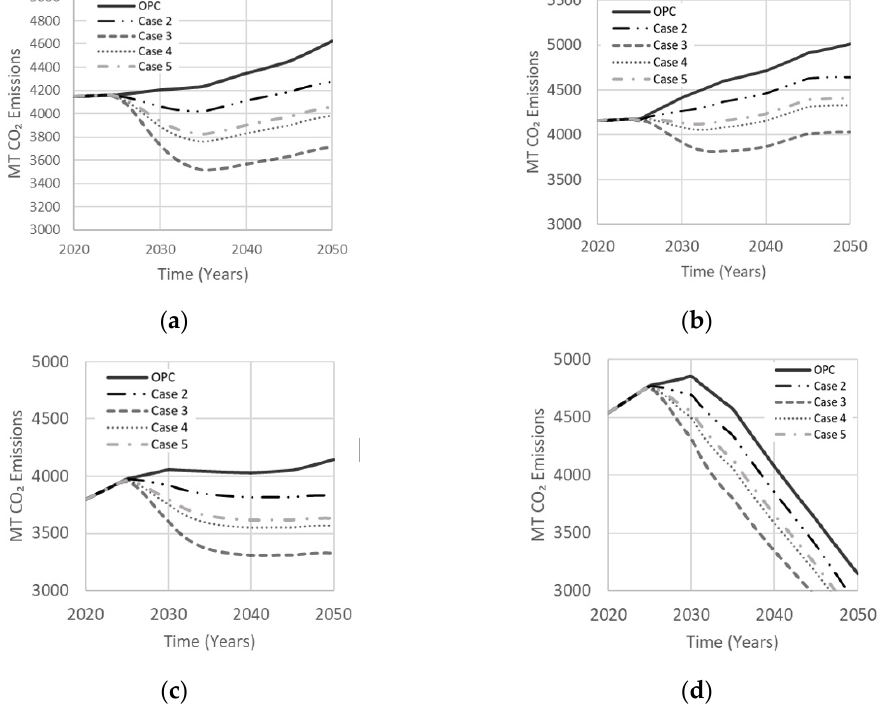
Figure 16. Effect of the binary precursor system on net emissions in ( a ) Low Variability Scenario; ( b ) High Variability Scenario; ( c ) Carbon Tax Increase Scenario; ( d ) Population Stabilization Scenario. Table 3. Binary precursor system.